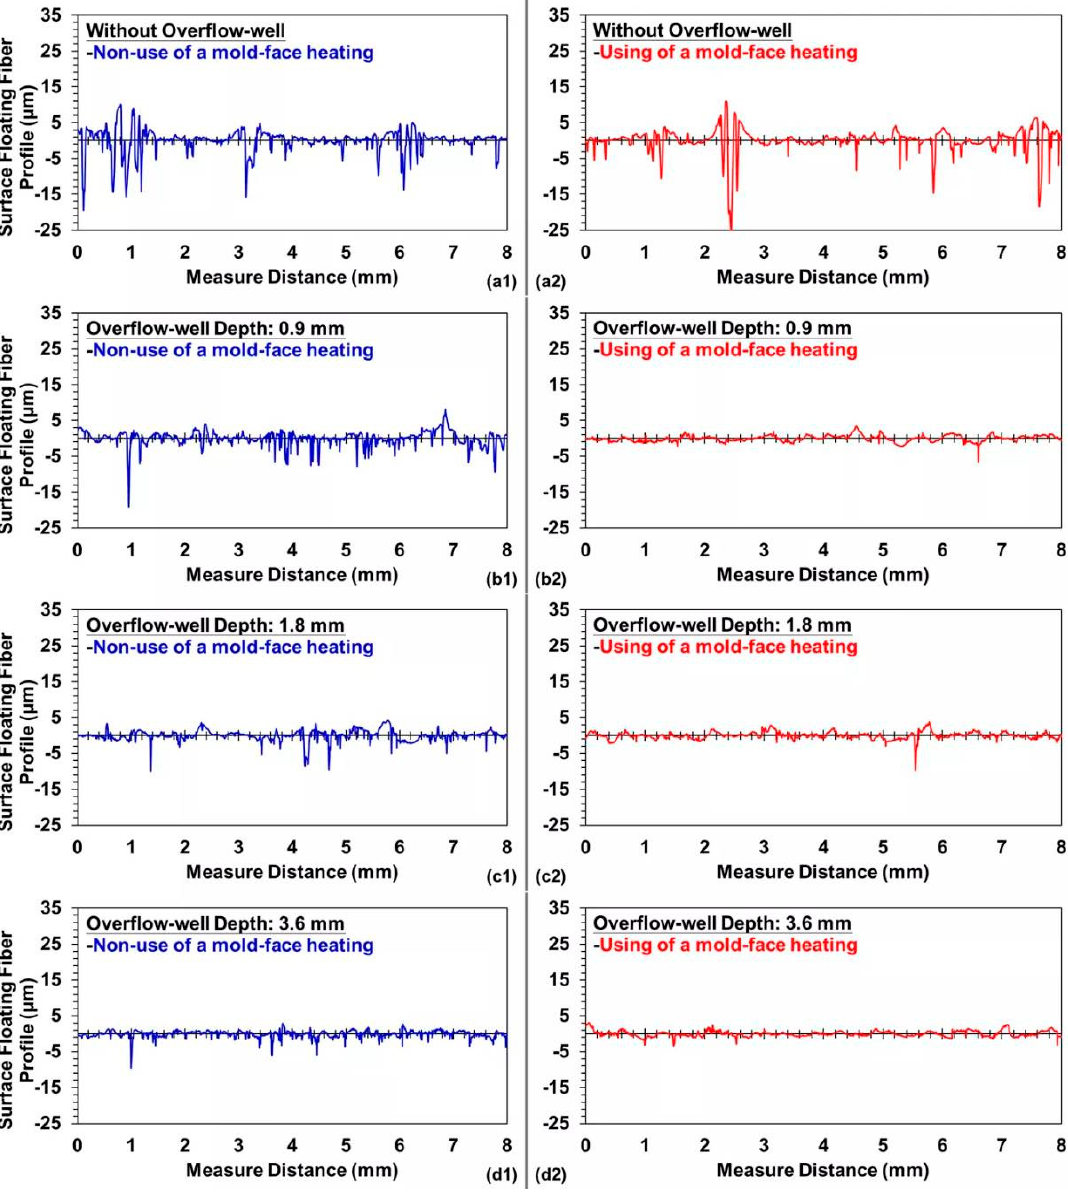
Figure 4. Variation in the presence of surface-floating fibers with and without the use of mold-face heating: ( a1 ) and ( a2 ) without overflow-well; ( b1 ) and ( b2 ) with an overflow well having a depth of 0.9 mm; ( c1 ) and ( c2 ) with an overflow-well having a depth of depth of 1.8; and ( d1 ) and ( d2 ) with an overflow-well having a depth of 3.6 mm.